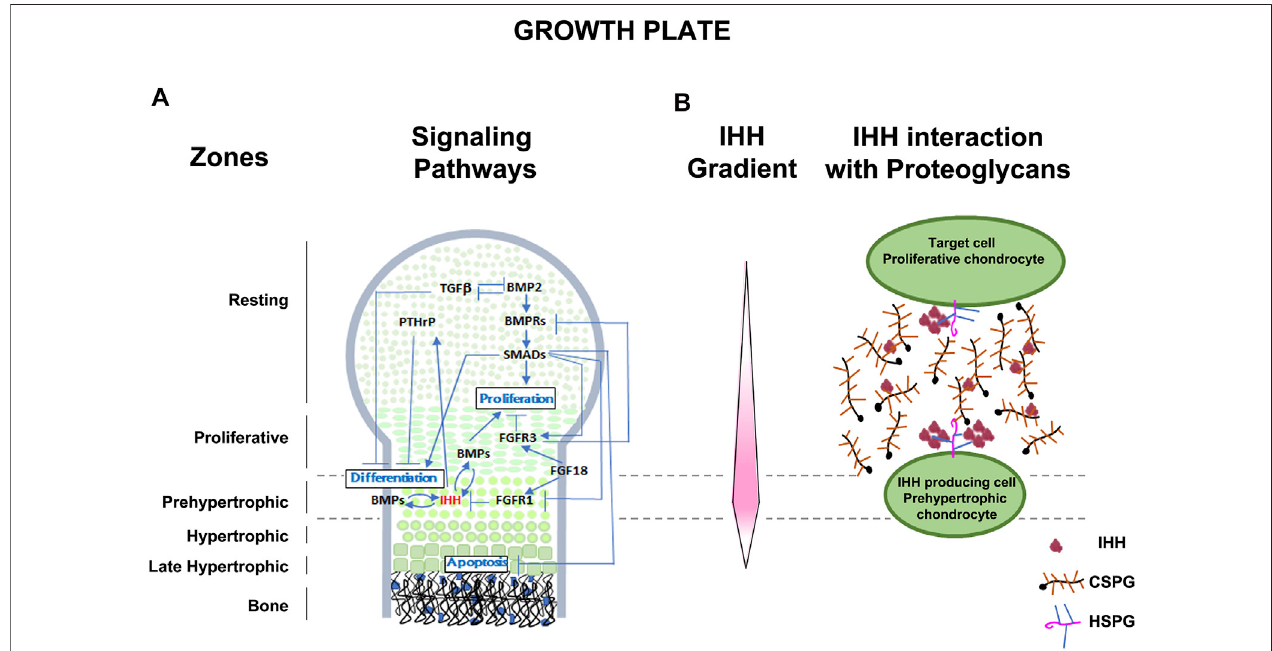
FIGURE 1 | Schematic representation of the developing growth plate. (A) Zones of chondrocyte differentiation and known signaling pathways associated with chondrocyte proliferation, differentiation, and apoptosis are indicated. (B) Representation of the Indian hedgehog (IHH) gradient (protein concentration represented in pink intensity) and the interactionof IHH with extracellular CSPGsand plasmamembrane associated HSPGs. IHH issecreted by prehypertrophicchondrocytes and the extended diffuse gradient expands to act on resting and proliferative chondrocytes. Extracellular matrix CSPGs help establish and maintain the extent of the diffusion gradient and protect IHH from degradation. Membrane associated HSPGs with higher af fi nity for IHH, act at the cell surface to bring IHH close to the plasma membrane for interaction with its receptors. Levels of multimerization of IHH is also dependent on lipoprotein particles not depicted here.